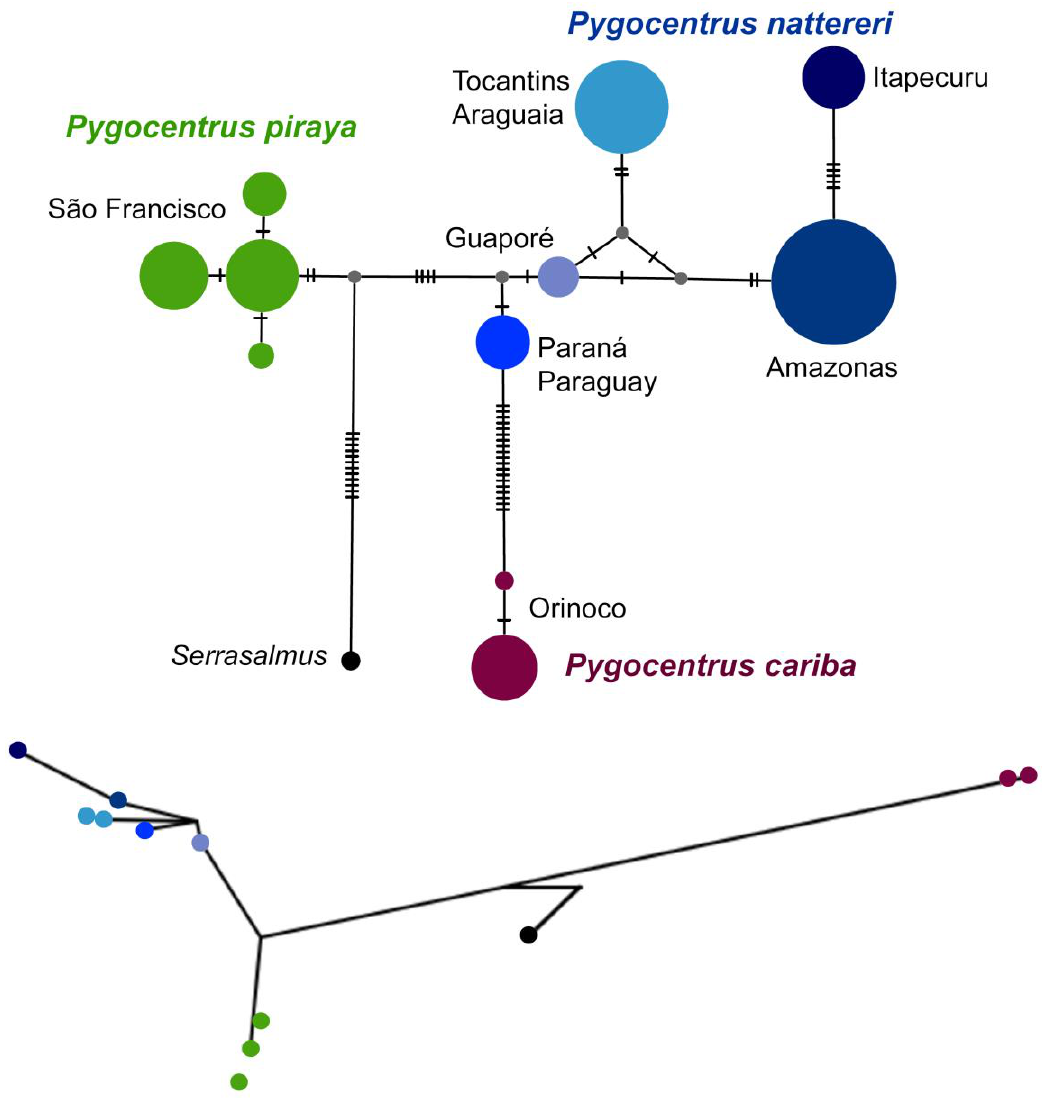
Figure 4. Haplotype network (above) and PhyloMap-PTP (below) showing the distribution of the 11 distinct haplotypes of Pygocentrus .